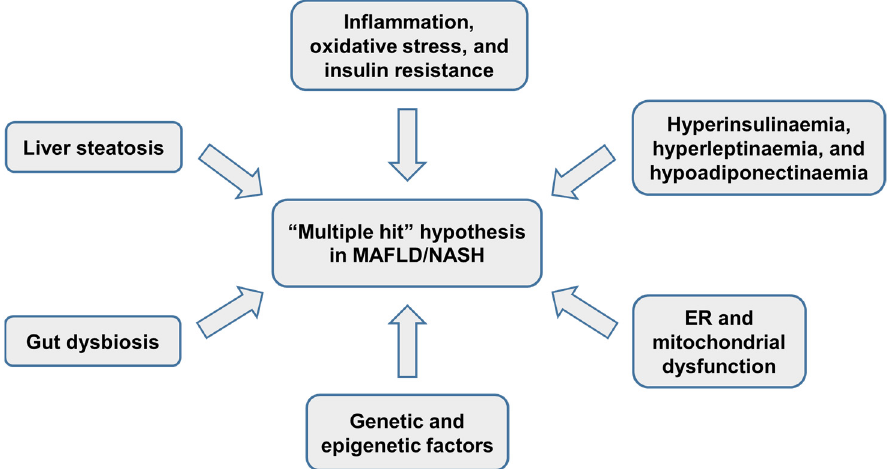
Figure 2. Multiples hits induce MAFLD and NASH. Lipids’ accumulation in the liver alters many different aspects of hepatocytes. Inflammation, oxidative stress, insulin resistance, hormones dysregulation, gut dysbiosis, organelle integrity and function, as well as genetic and epigenetic factors, are implicated in the development and progression of MAFLD and NASH. Abbreviations: MAFLD, metabolic dysfunction-associated fatty liver disease; NASH, nonalcoholic steatohepatitis; ER, endoplasmic reticulum.